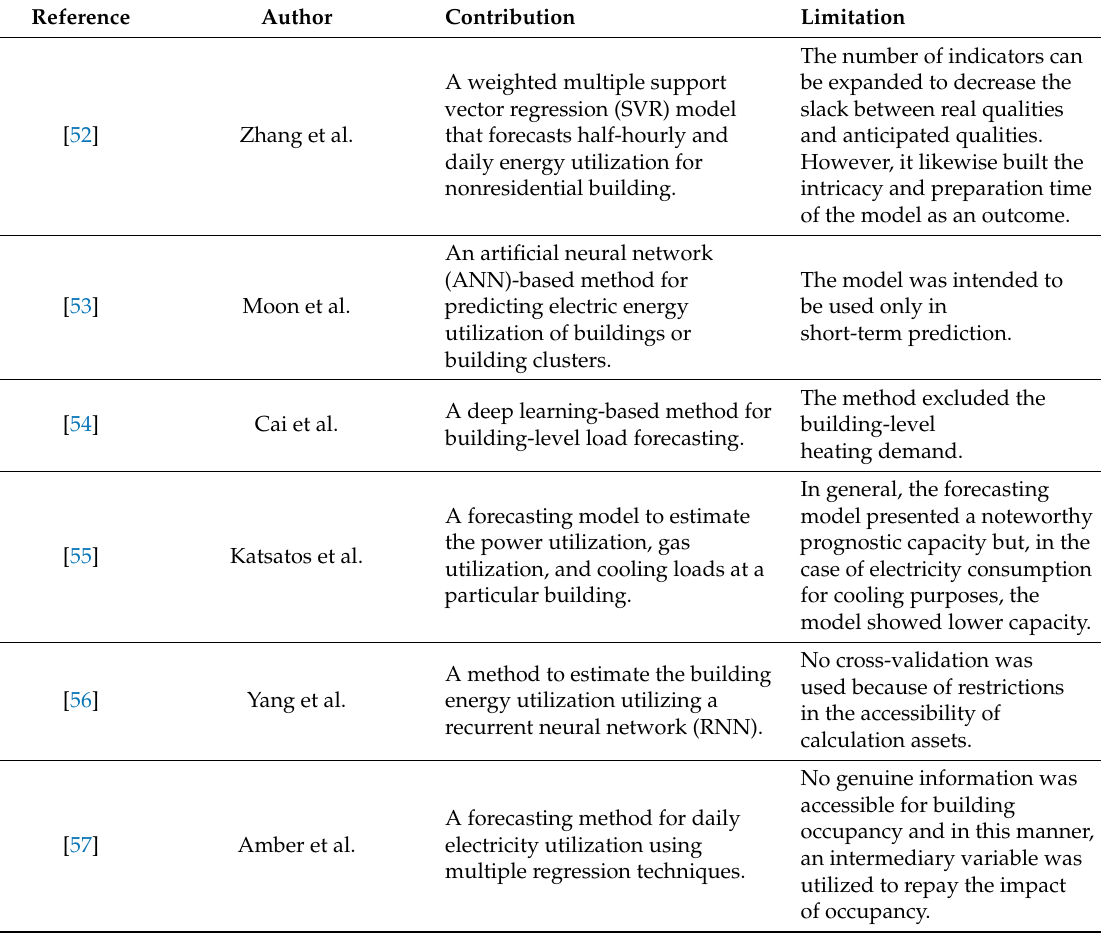
Table 2. Summary of previous research papers and their contributions to data-driven